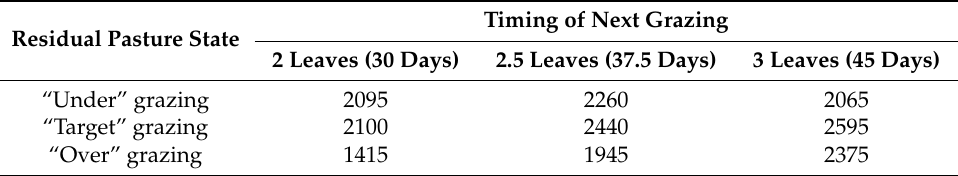
Table 1. Estimated effect of different regrowth intervals on the net amount of herbage accumulated (kg ¨ DM/ha) during regrowth of pastures mown to about 1150 (“Over”), 1500 (“Target”) or 1850 (“Under”) kg ¨ DM/ha residual pasture mass. Data apply to just a single regrowth event, in autumn, in Canterbury New Zealand, using the results shown in Figure